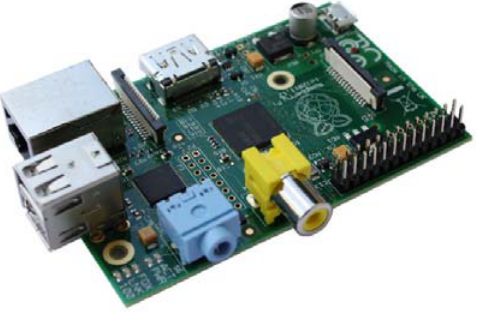
Figure 1. The Raspberry PI Model B (source: Raspberry PI